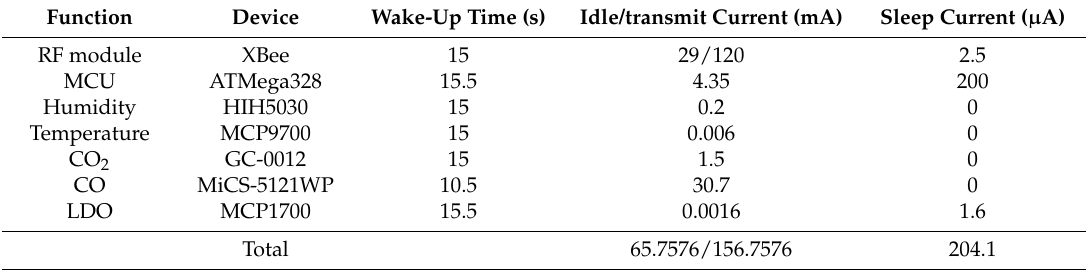
Table 1. Power consumption for each component on the sensor node (current value from datasheet).